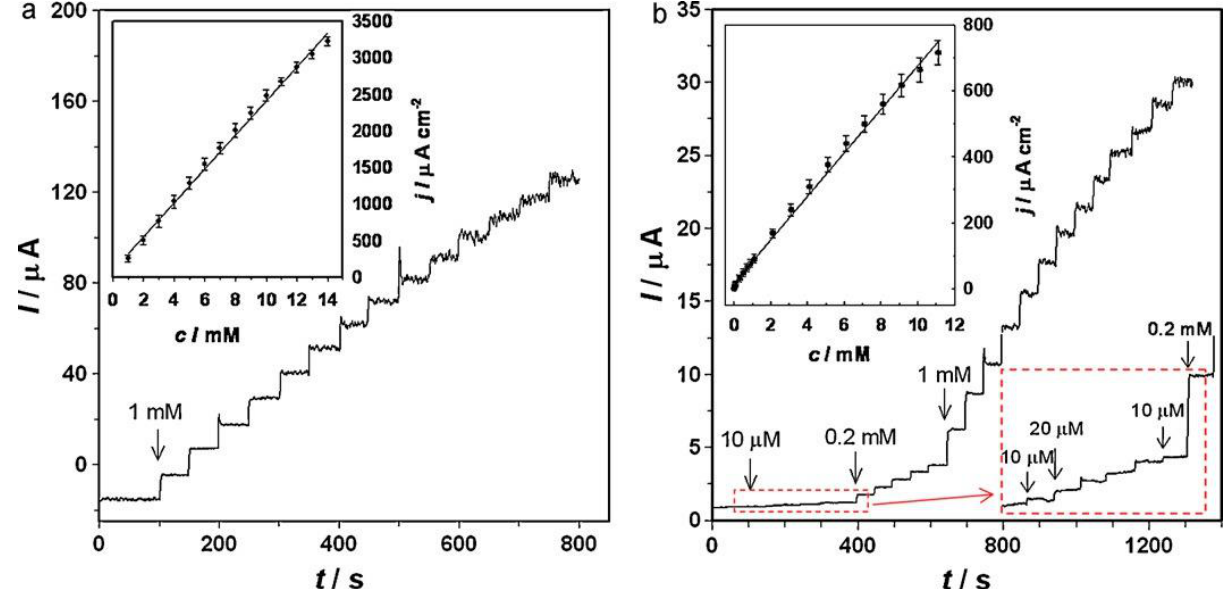
SO at −0.15 V (Reference electrode: 2 4